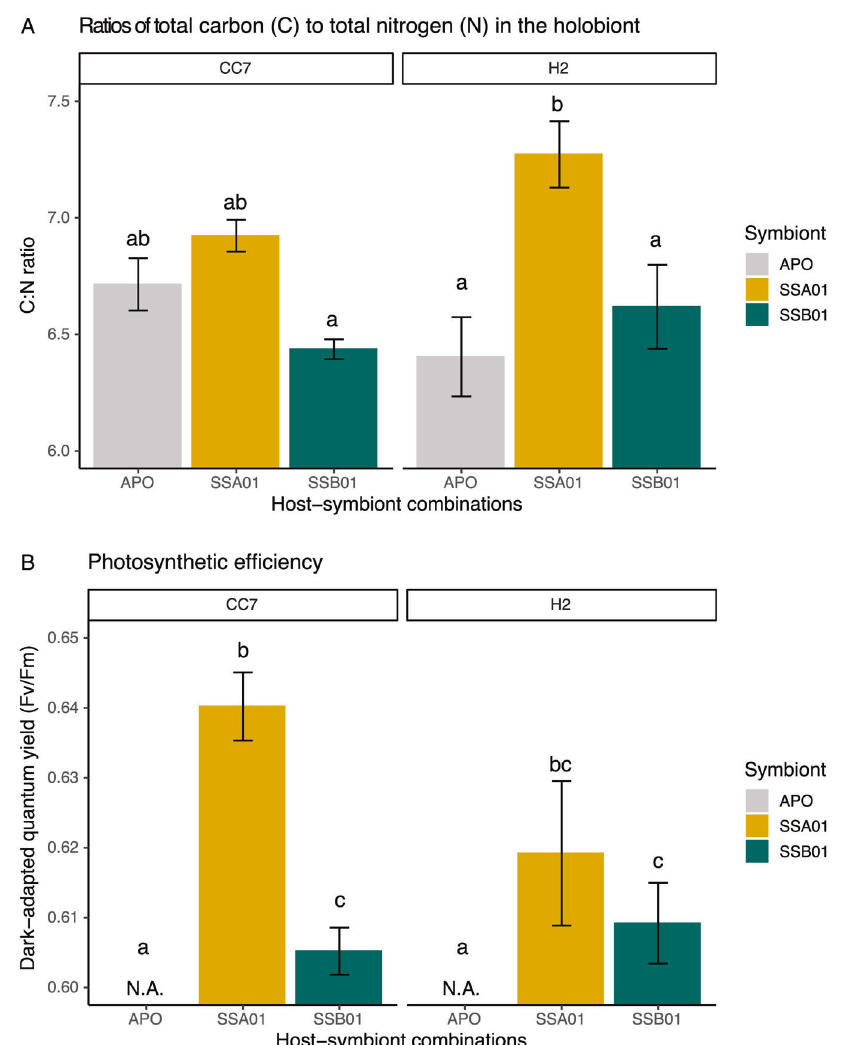
Fig. 2 Physiology of six host-symbiont combinations of Aiptasia. A Ratios of total carbon to total nitrogen. B Photosynthetic ef fi ciency of photosystem II. All data are presented as mean ± SE ( n = 5 animals each). Different letters above bars indicate signi fi cant differences between groups (two-way ANOVA with Tukey HSD, P <